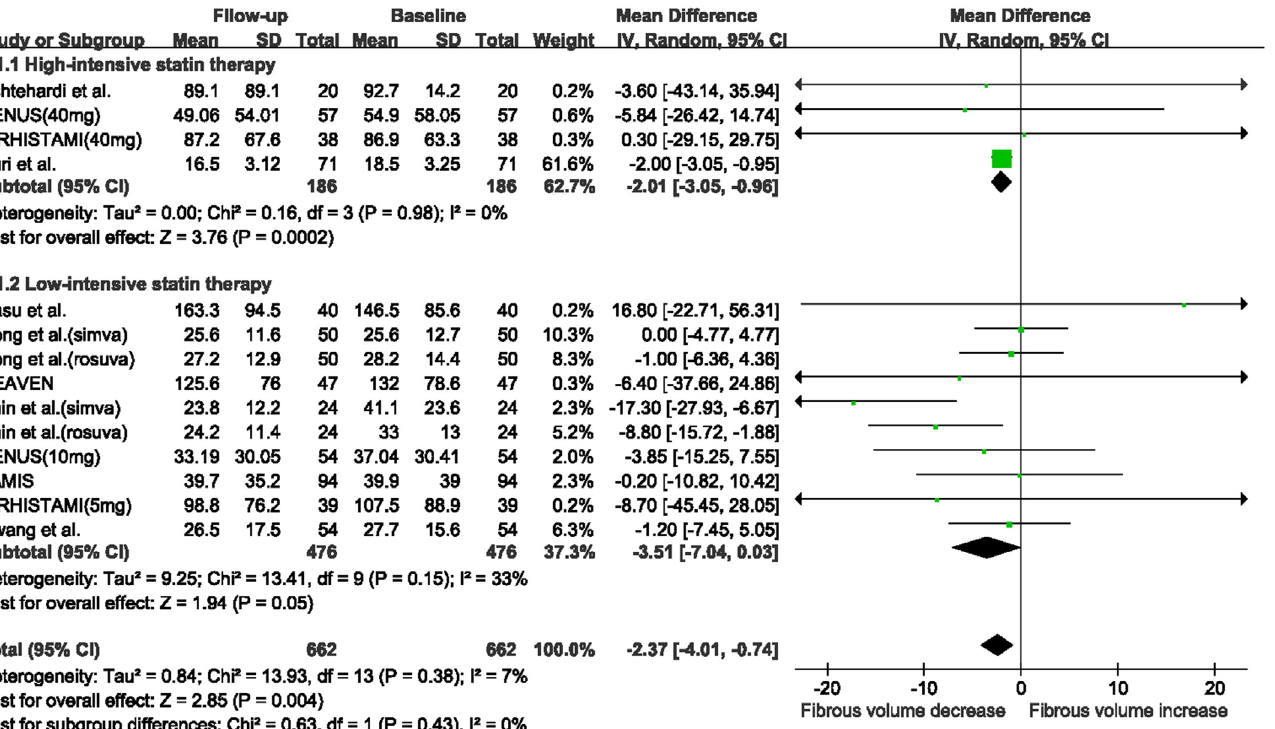
Fig 6. Meta-analysis of changes in fibrous volume with statin therapy using stratified analysis based on the intensity of statin therapy. Abbreviations: CI: confidence interval; SD: standard deviation.